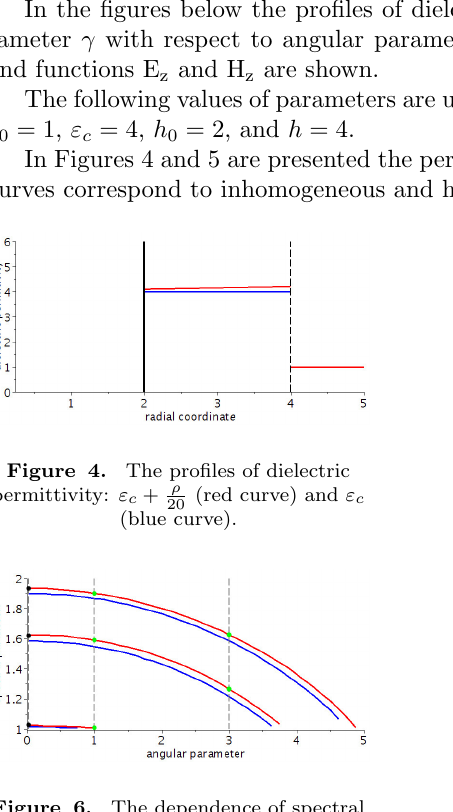
Figure 6. The dependence of spectral parameter γ with respect to m in case of ω = 1. Red and blue colours corresponds to ε c + ρ and ε c , respectively. 20